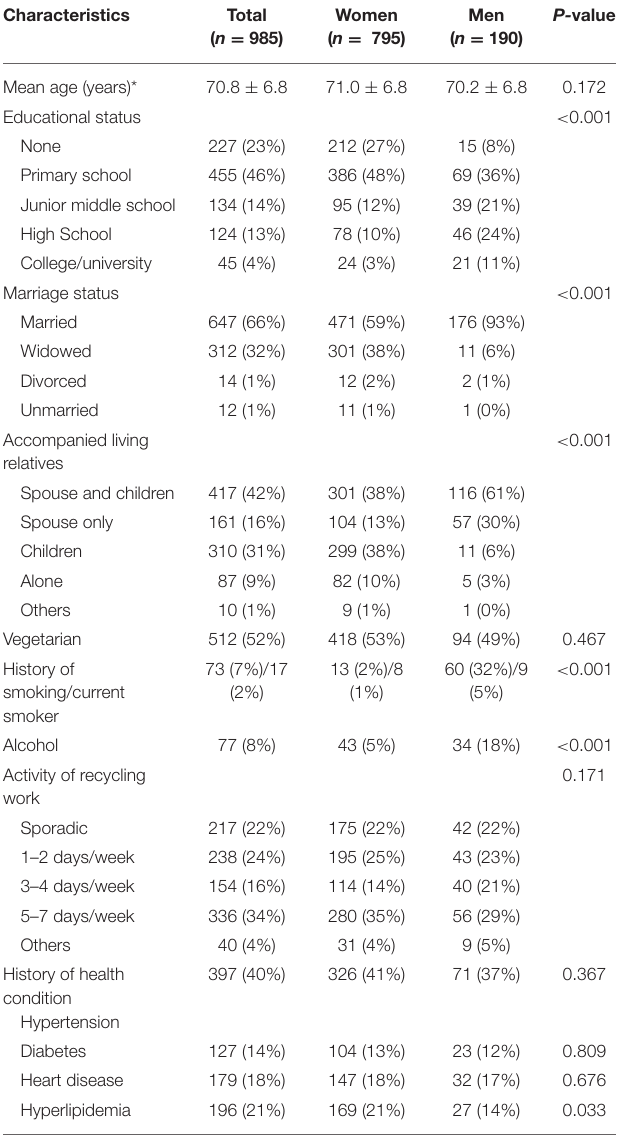
TABLE 1 | Demographic data of 985 volunteers.